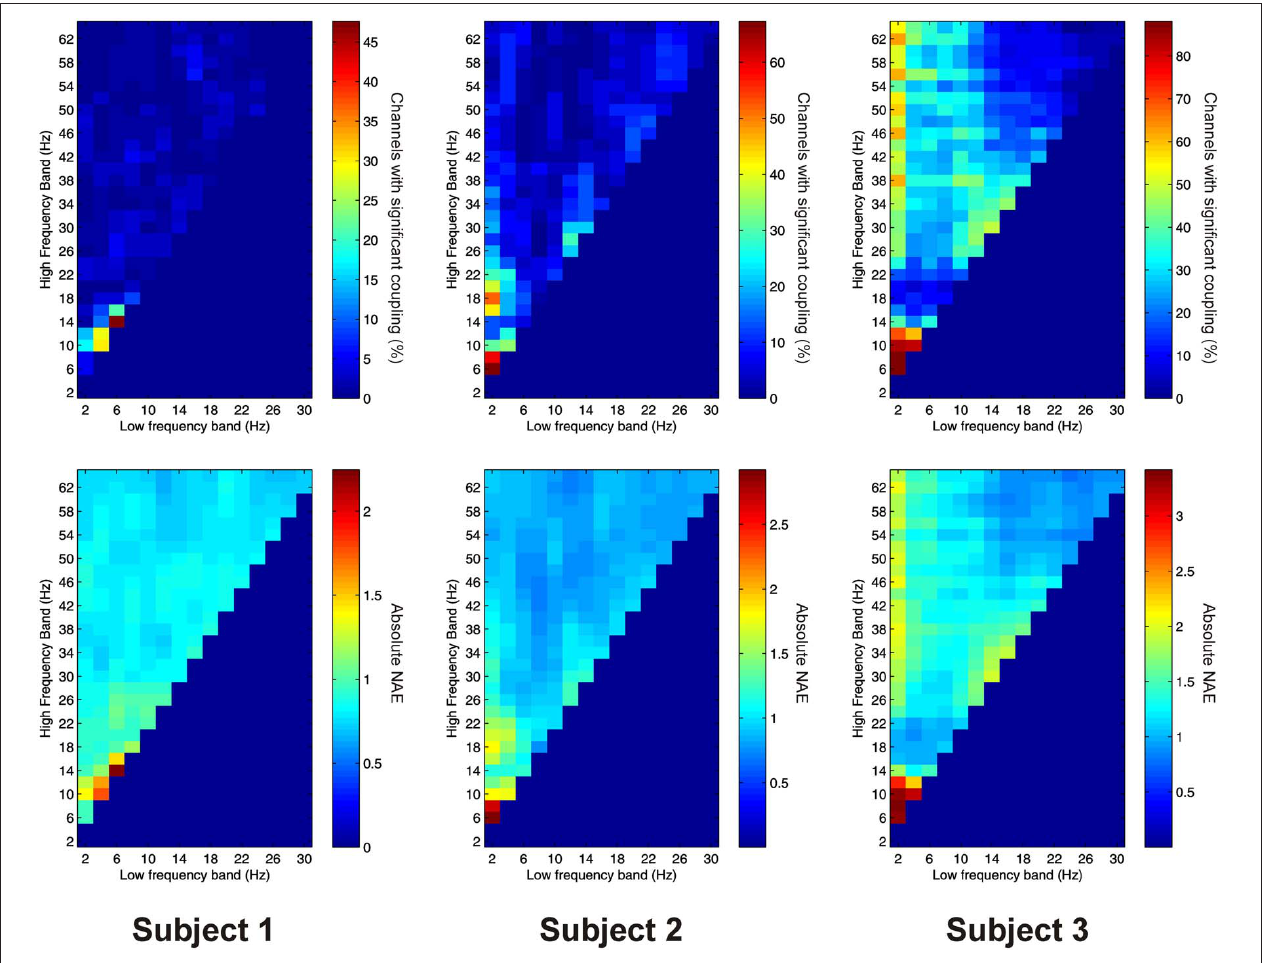
FIGURE 9 | Top row: Proportion of channels showing significant cortico-thalamic AAC (coupling between a low-frequency in the PFC and a high-frequency in the thalamus) (Subject 1 left, Subject 2 middle, Subject 3